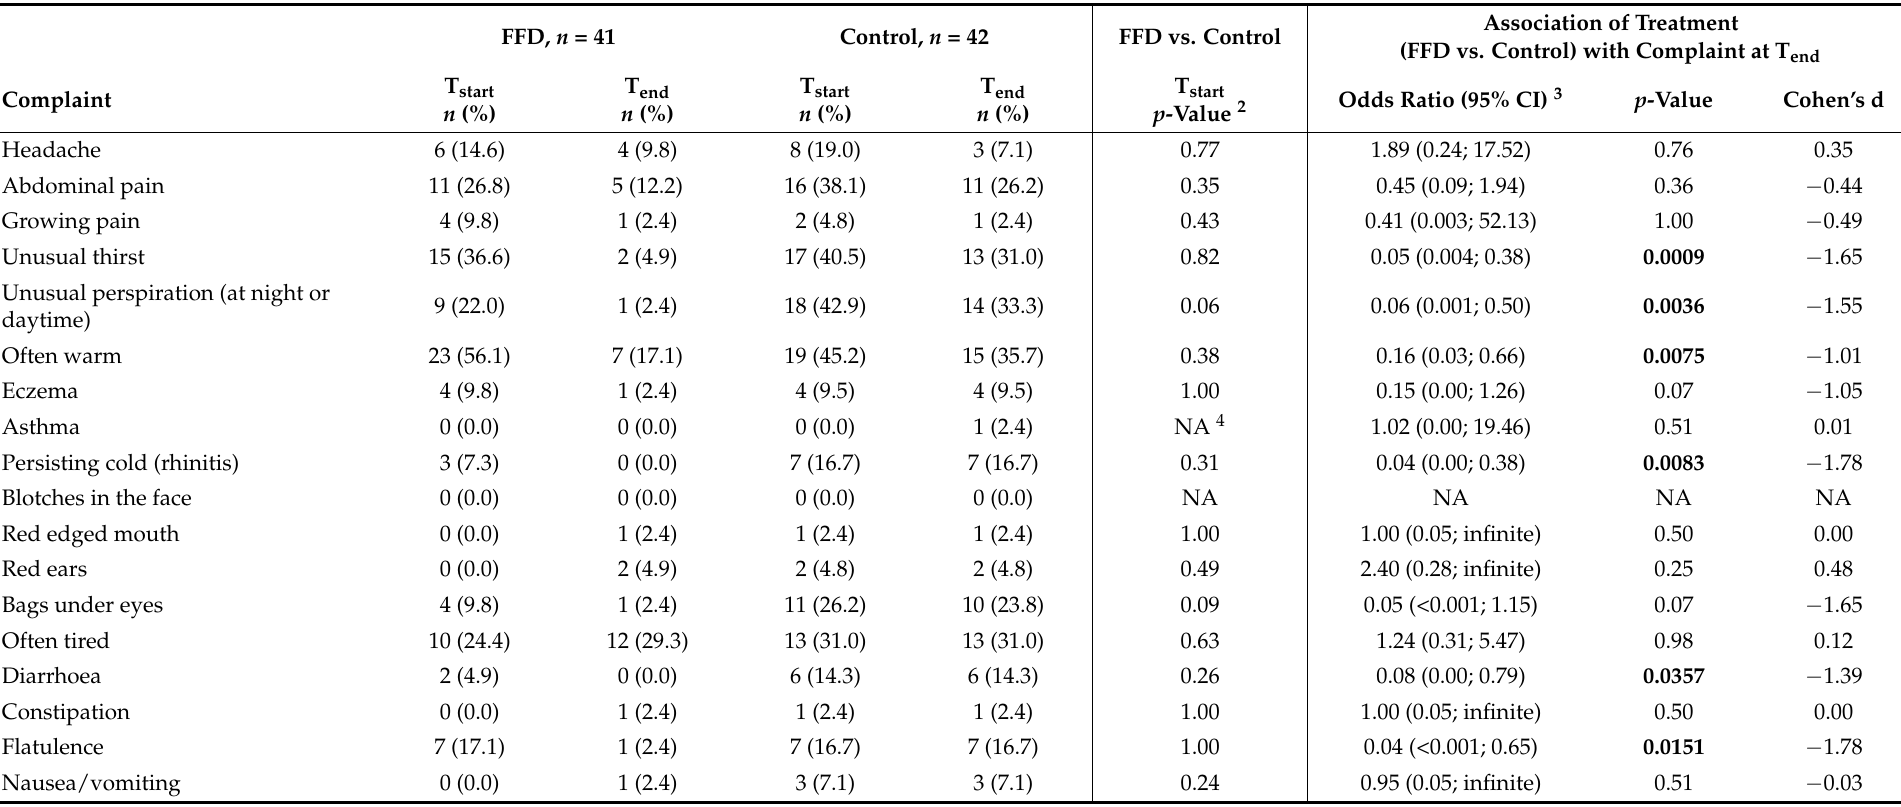
Table 3. Distribution and statistical analysis of presence of 21 physical complaints in the few-foods diet (FFD) group and control group of the INCA study, scored using the physical complaint questionnaire 1 . FFD, n = 41 Control, n = 42 FFD vs. Control